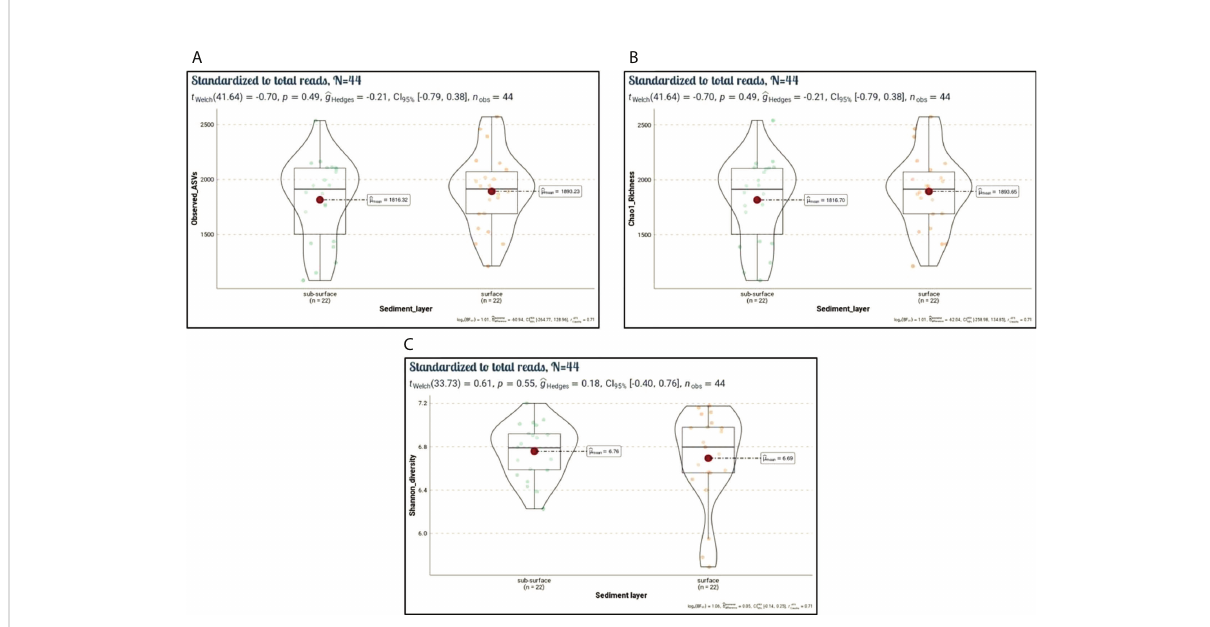
FIGURE 8 Alpha diversity indices (S obs , Chao1, Shannon). Violin plots showing spatial differences in microbiota diversity among surface and sub-surface sediment sites (n = 44). (A) Number of observed species (S obs , p = 0.49), (B) Chao1 richness (Chao1, p = 0.49), and (C) Shannon diversity index (p = 0.55). Statistical differences among surface and sub-surface sites were calculated using Student or Welch ’ s t-test .